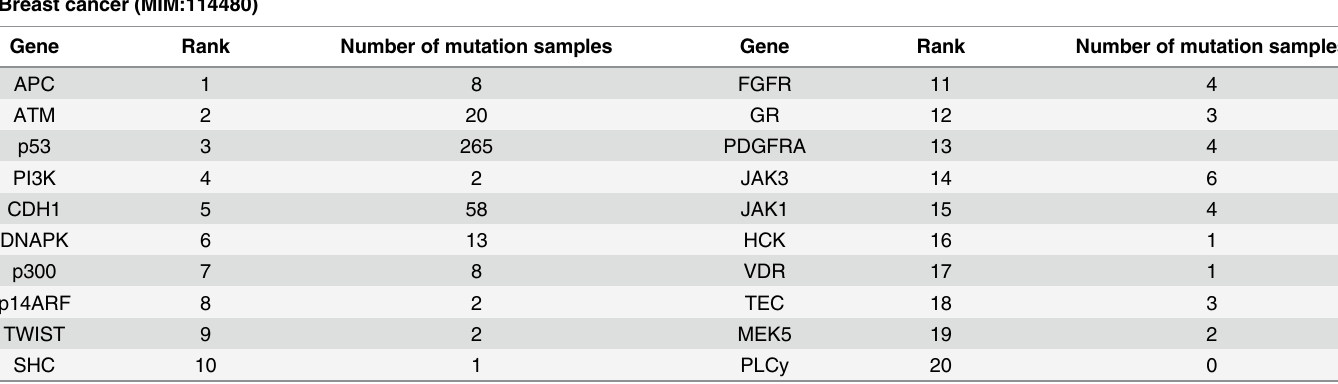
Table 7. The top ranked candidate genes for Breast cancer in Cancer Signaling Map. Breast cancer (MIM:114480) Gene